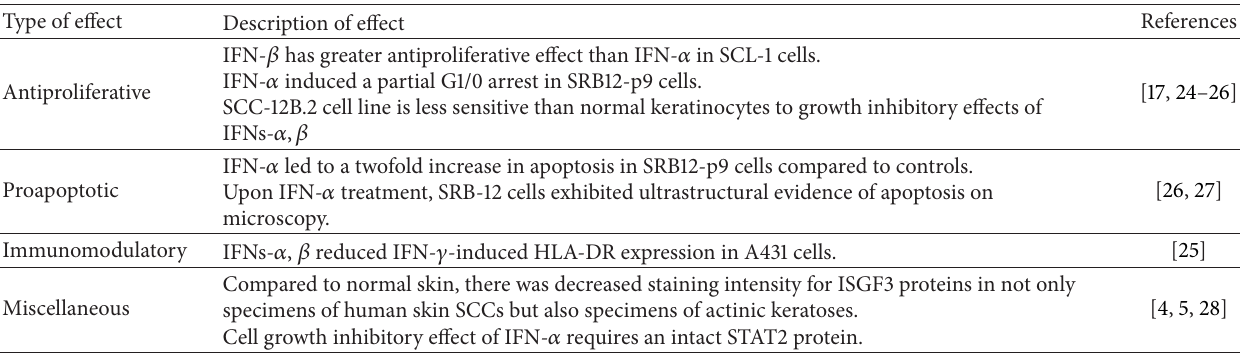
Table 2: Effect of type I Interferon on cutaneous squamous cell